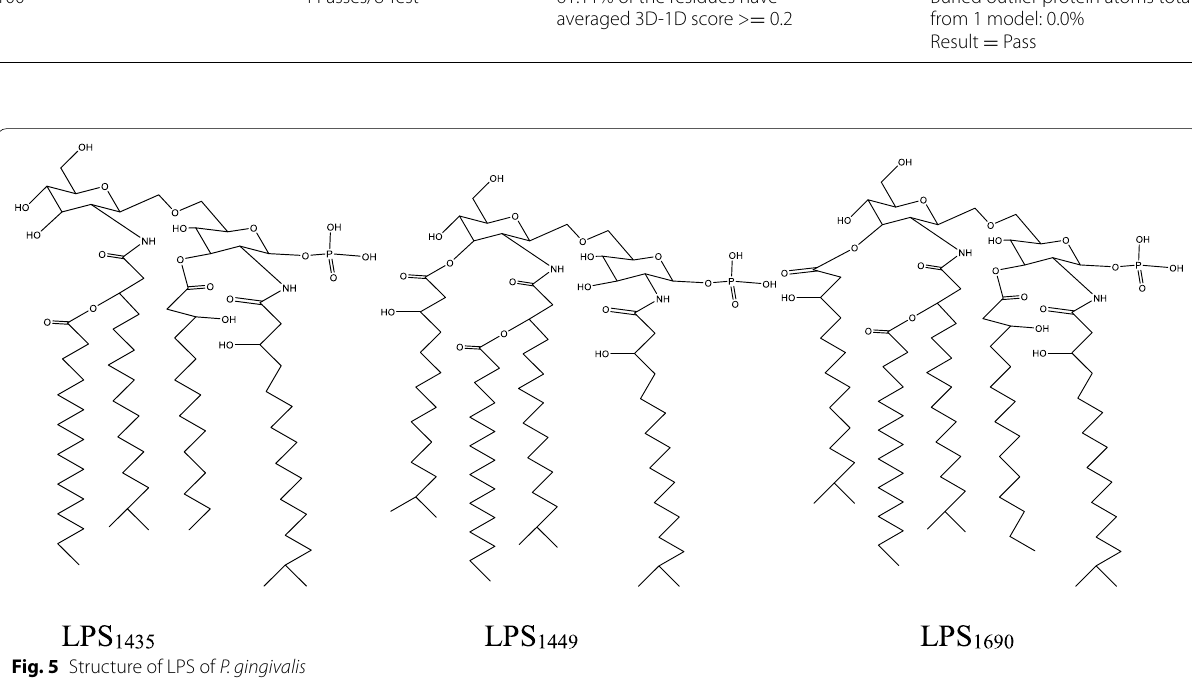
Fig. 5 Structure of LPS of P.